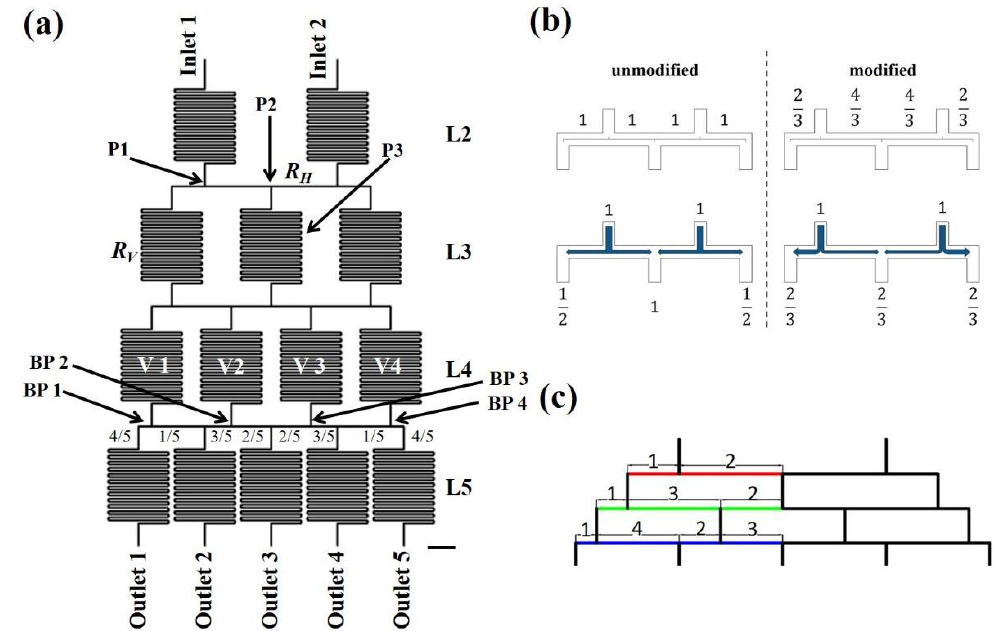
Figure 1. ( a ) Five-layered, Christmas-tree-like MGG with two inlets and five outlets. Scale bar = 2 mm. ( b ) Top: Unmodified and modified three-outlet designs. Bottom: flow of liquids upon branching points. ( c ) Modification ratios of a five-outlet design. P1~P3: Point 1~Point 3; L2~L5: Layer 2~Layer 5; BP1~BP4: Branching Point 1~Branching Point 4; V1~V4: Vertical channels; R H : resistance of